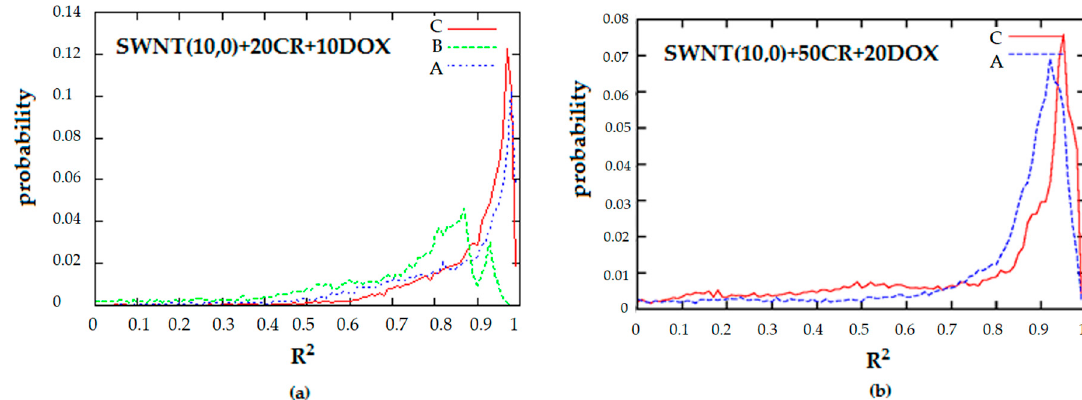
Figure 9. Histograms of the planarity of a single CR molecule, R 2 . ( a ) SWNT (10.0) complexed with 20 molecules of CR and 10 molecules of DOX; ( b ) SWNT (10.0) complexed with 50 molecules of CR and 20 molecules of DOX; (A—neutral pH, B—medium pH, C—acidic pH).